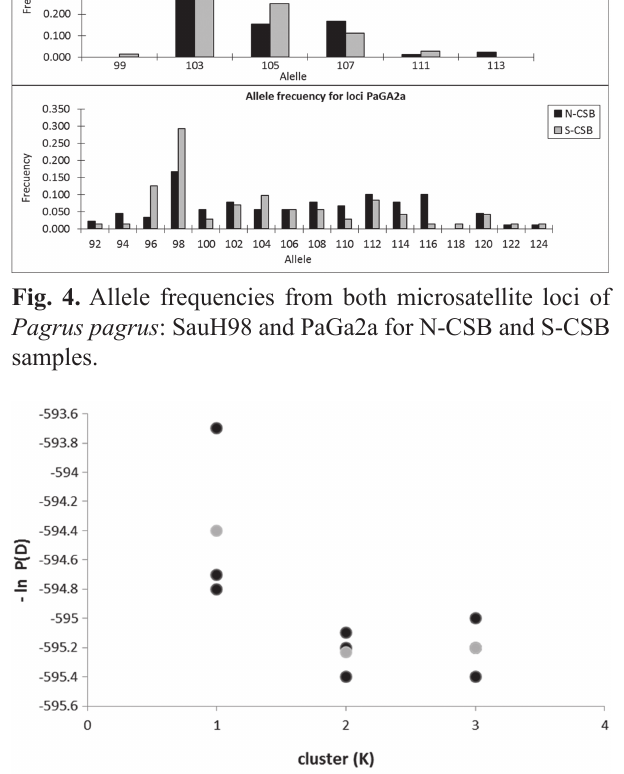
Fig. 5. Likelihood values for inferred number of genetic clusters (K) from STRUCTURE of Pagrus pagrus . The black circles represent three simulation values for each cluster, and the grey circle the average value.